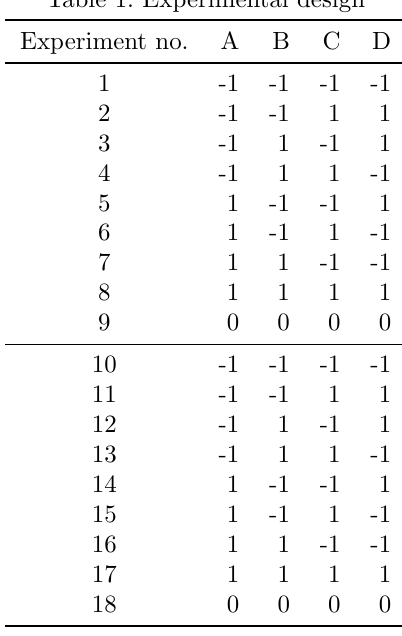
Table 1: Experimental design Experiment